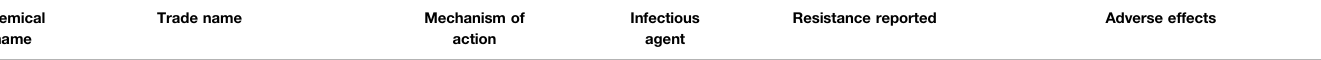
TABLE 2 | ( Continued ) Antiviral medications for the treatment of